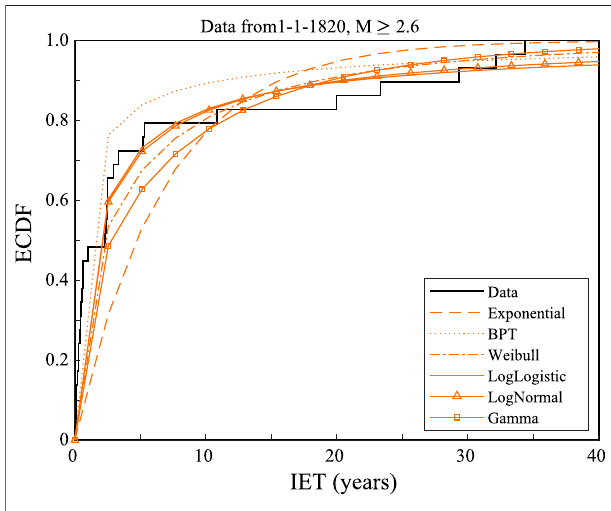
FIGURE 5 | Model fi t to the ECDF of IETs from events with M ≥ 2.6 since 1820s.